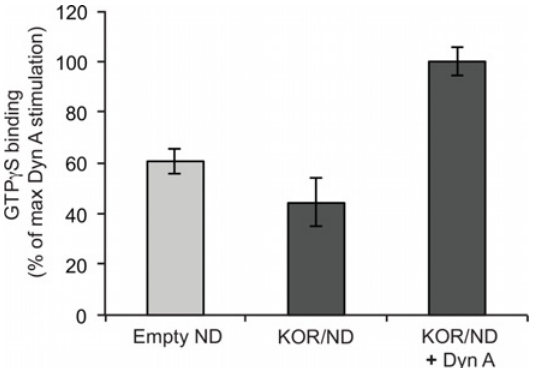
Fig 5. Isolated KOR reconstituted in Nanodiscs activated G i protein. BODIPY FL GTP γ S was used to confirm G α i protein activation by KOR after isolation and reconstitution into Nanodiscs. The intrinsic activity of G proteins was measured in the presence of empty Nanodiscs (light grey, Empty ND). Compared to KOR/ Nanodisc sample without agonist stimulation (KOR/ND, dark grey), the fluorescence from BODIPY FL GTP γ S binding to G α i increased by 56% when the KOR/Nanodisc sample was stimulated with 1 μ M dynorphin A (1 – 17) (KOR/ND + Dyn A, dark grey). Error bars represent standard error of the mean between two independent